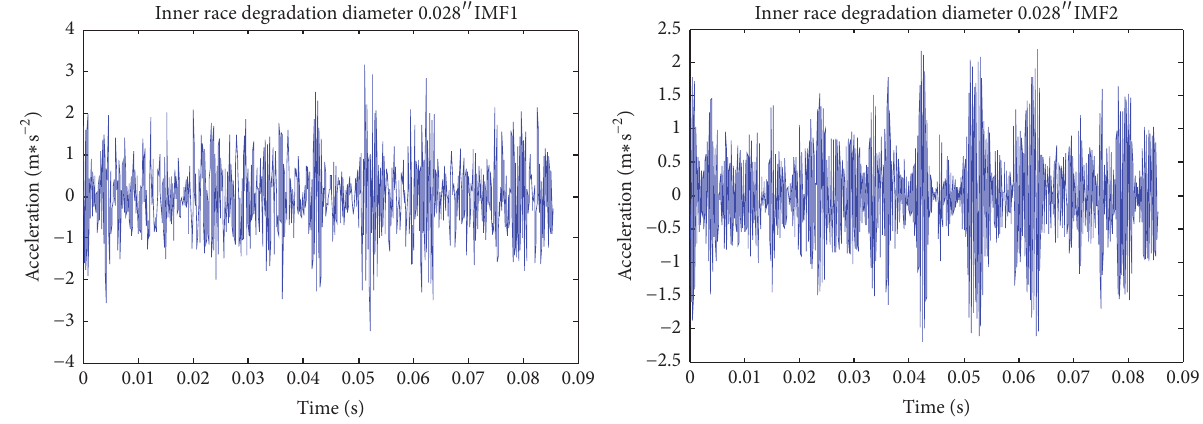
Figure 8: The sensitive IMF components of the five degradation states.